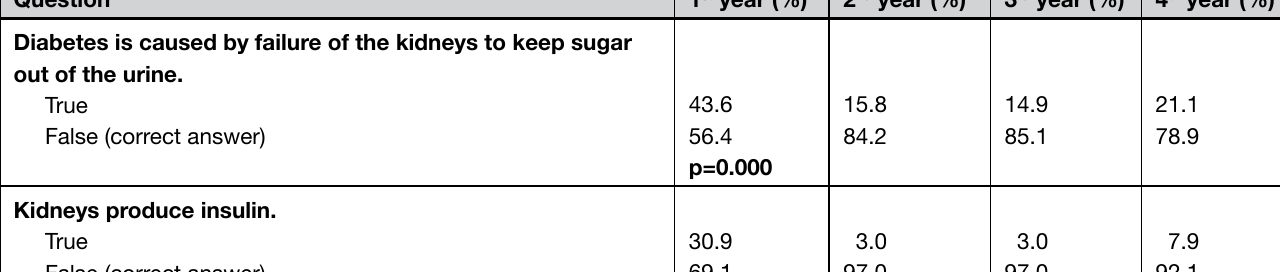
Table 2: Significant associations between year of study (1 st year) and knowledge of diabetes mellitus Question